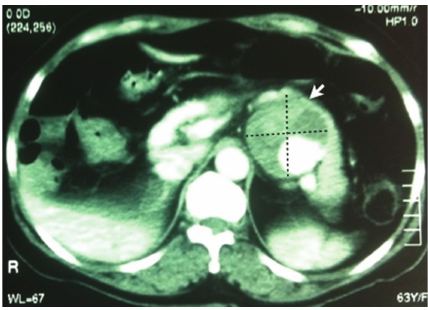
Figure 1: Axial section of CT of the abdomen with intravenous contrast. The arrow indicates the underlying lesion to the pancreas (splenic artery